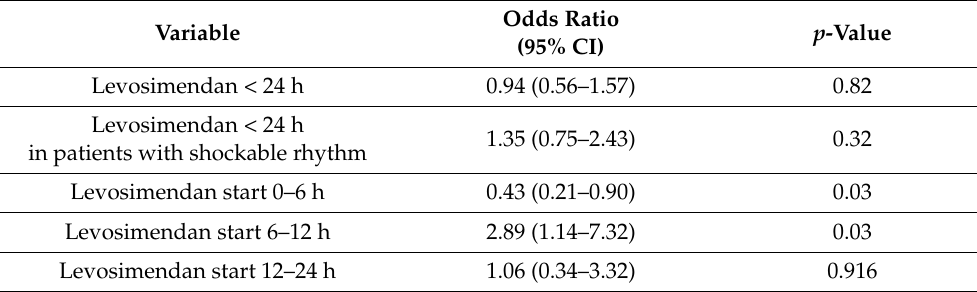
Table 3. Multivariable regression analyses showing the association with Levosimendan treatment and 30-day mortality in out-of-hospital-cardiac arrest patients admitted to ICU in Stockholm, Sweden 2010–2016. All analyses were adjusted for age, sex bystander-CPR, witnessed event, myocardial infarction and initial